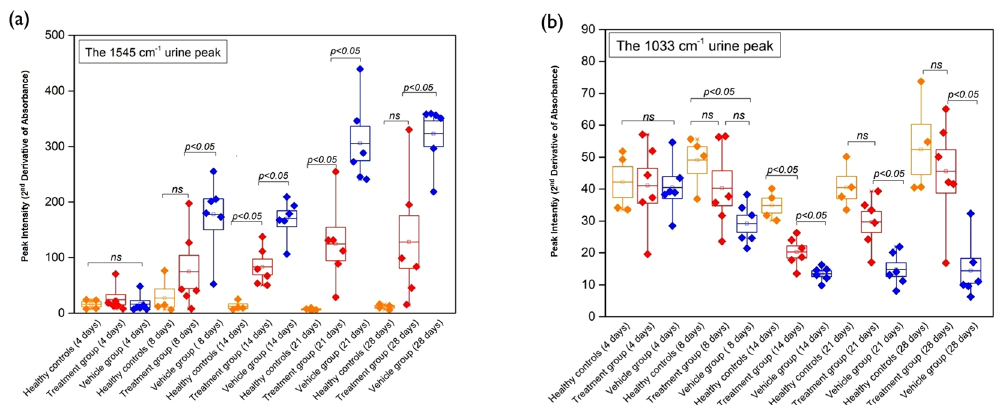
Figure 6. ( a ) Longitudinal study of the intensity of the urinary 1545 cm − 1 band in NTN rats treated with DXM (started after urine collections on day 4) (red) compared with the normal (orange) and vehicle-treated NTN rats (blue). It was apparent that the peak intensities were reduced in response to DXM treatment. ( b ) Longitudinal analysis of the intensity of the urinary 1033 cm − 1 band marker in the treatment group (red) compared with healthy controls (orange) and the vehicle group (blue). From day 14 to day 28, the vehicle treated group had a major reduction in the peak intensity whereas these changes in the spectral peaks were less in the treatment group ( p <